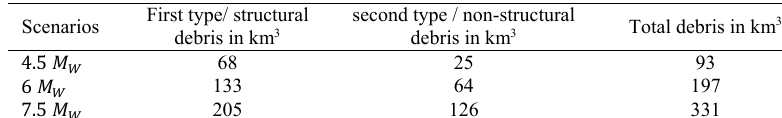
Table 2: Total amount of debris caused by Ray earthquake scenario